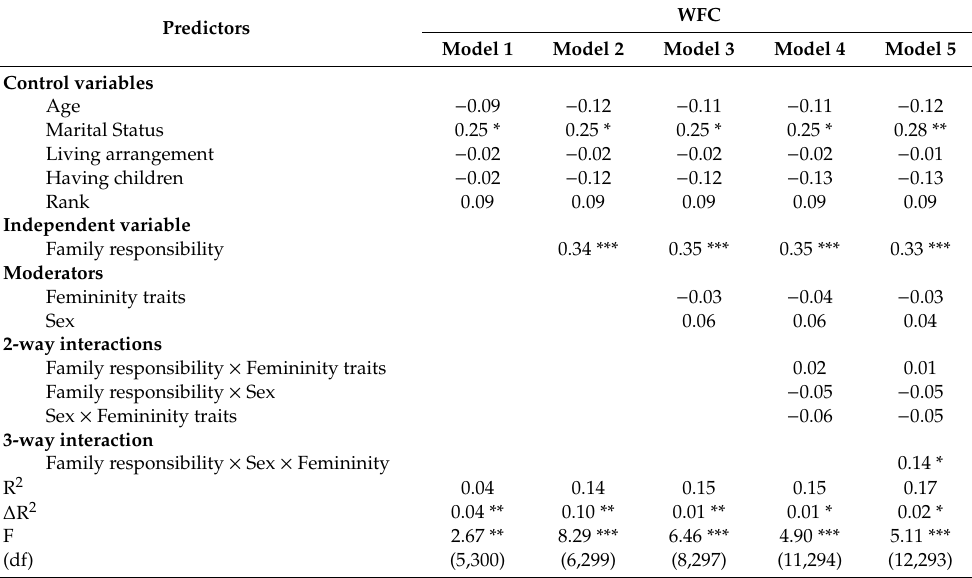
Table 5. Results of moderated regression on WFC: femininity